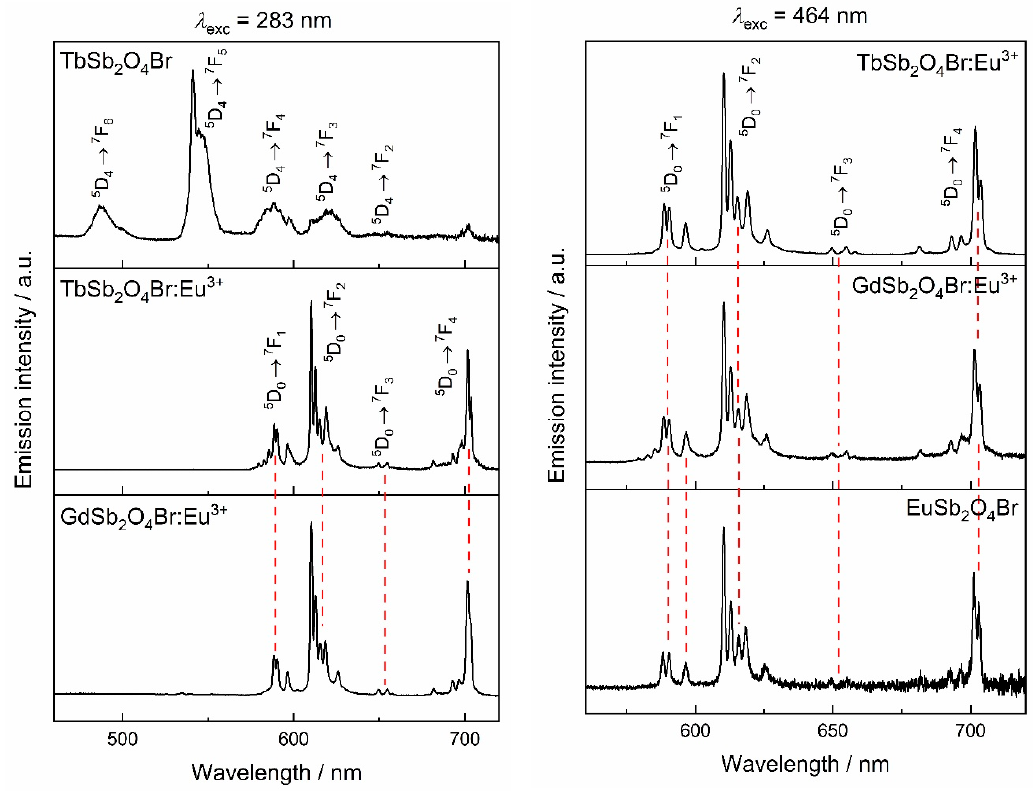
Figure 13. Left : emission spectra upon excitation at the charge-transfer band of the Ln 3 + matrix ( λ ex = 283 nm). Right : emission spectra excited in the characteristic Eu 3 + 7 F 0 → 5 D 2 transiton ( λ ex = 464 nm).